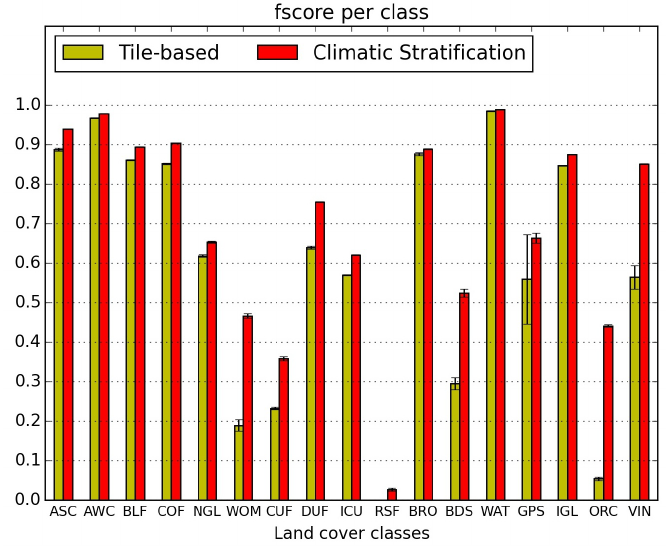
Figure 14. FScore per